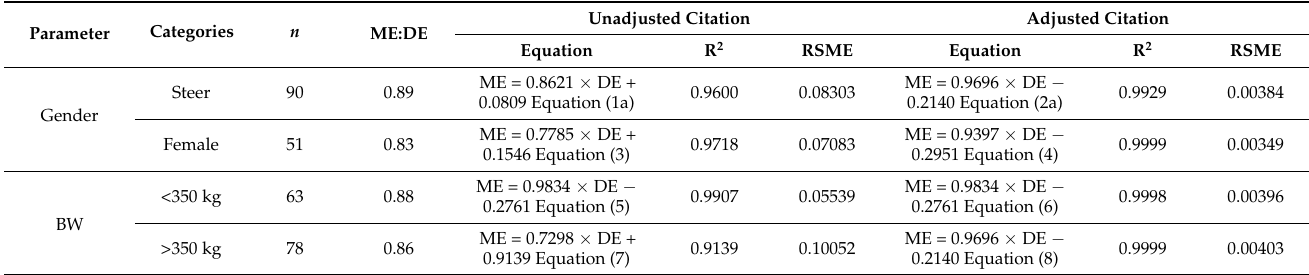
BW, body weight; DE, digestible energy; ME, metabolizable energy.